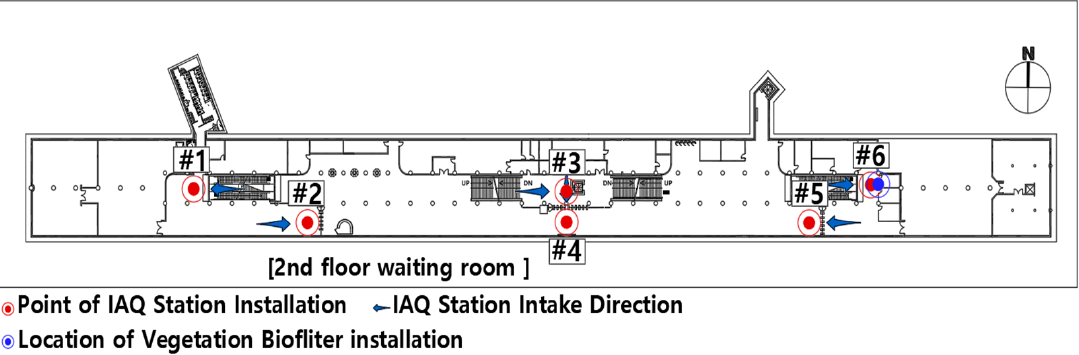
Figure 1. Installation area of the mockup biofilter.